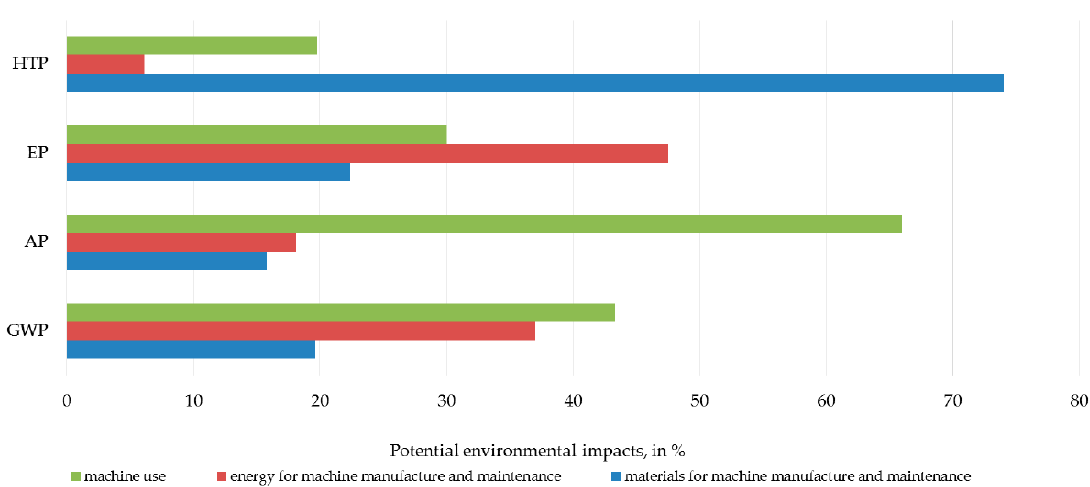
Figure 3. Potential environmental impacts in the categories human toxicity (HTP), eutrophication (EP), acidification (AP) and global warming (GWP), and divided in (i) maintenance and machine use (in green), (ii) energy consumption for machine manufacture (in red), and (iii) materials for machine manufacture and maintenance (in blue), in %.